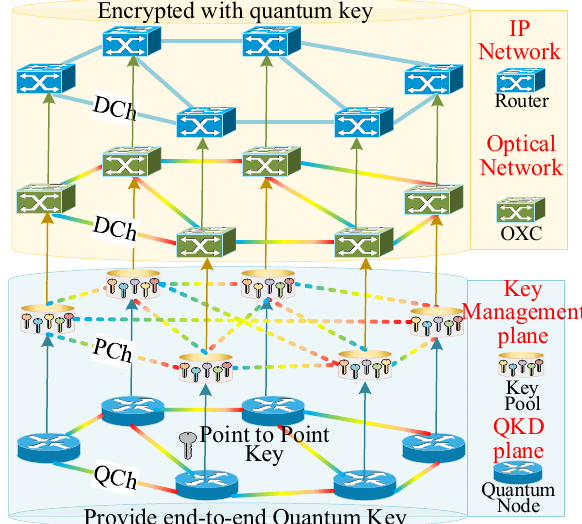
Figure 3. QKD over Optical Network Architecture.